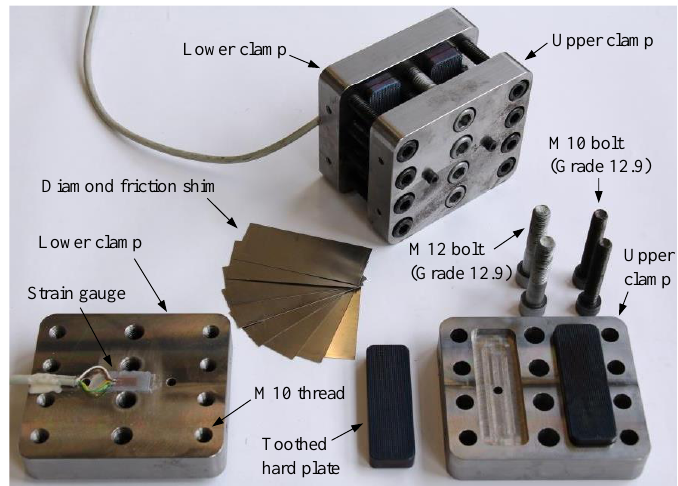
Figure 5. Different components of the developed mechanical clamping system.